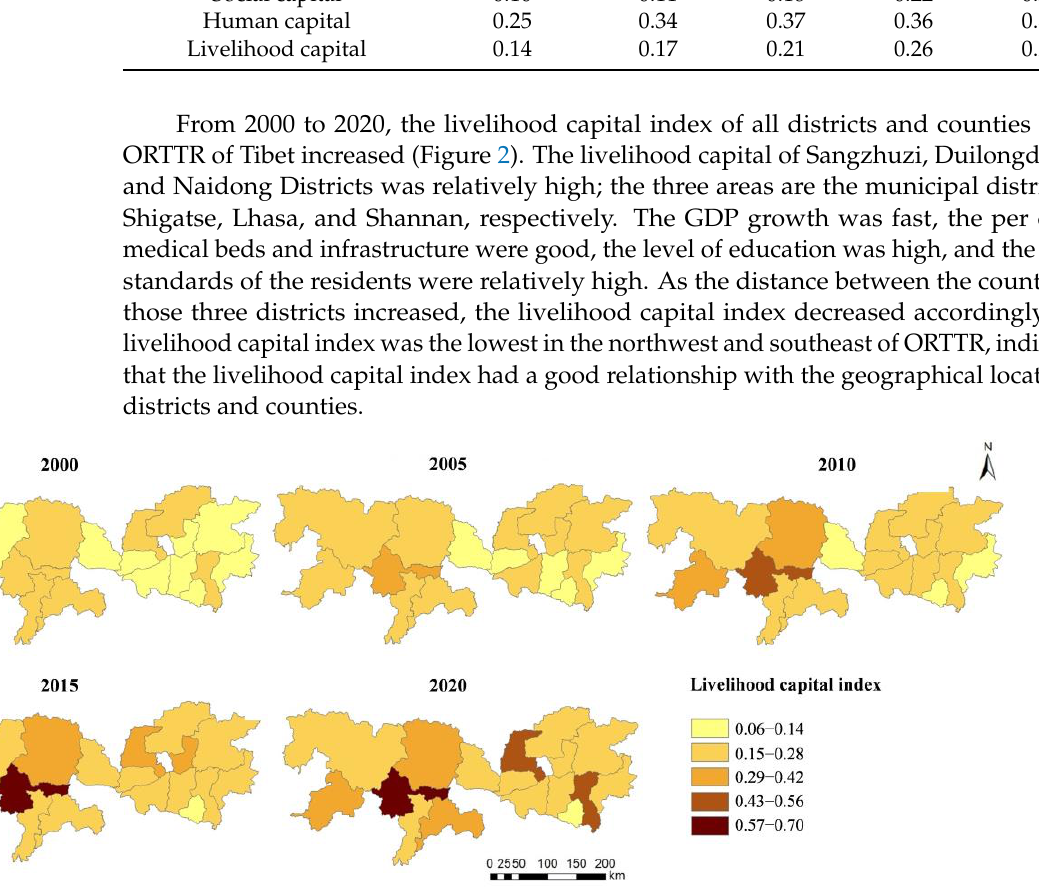
Figure 2. Spatiotemporal distribution of residents’ livelihood capital index in the ORTTR from 2000 to 2020.